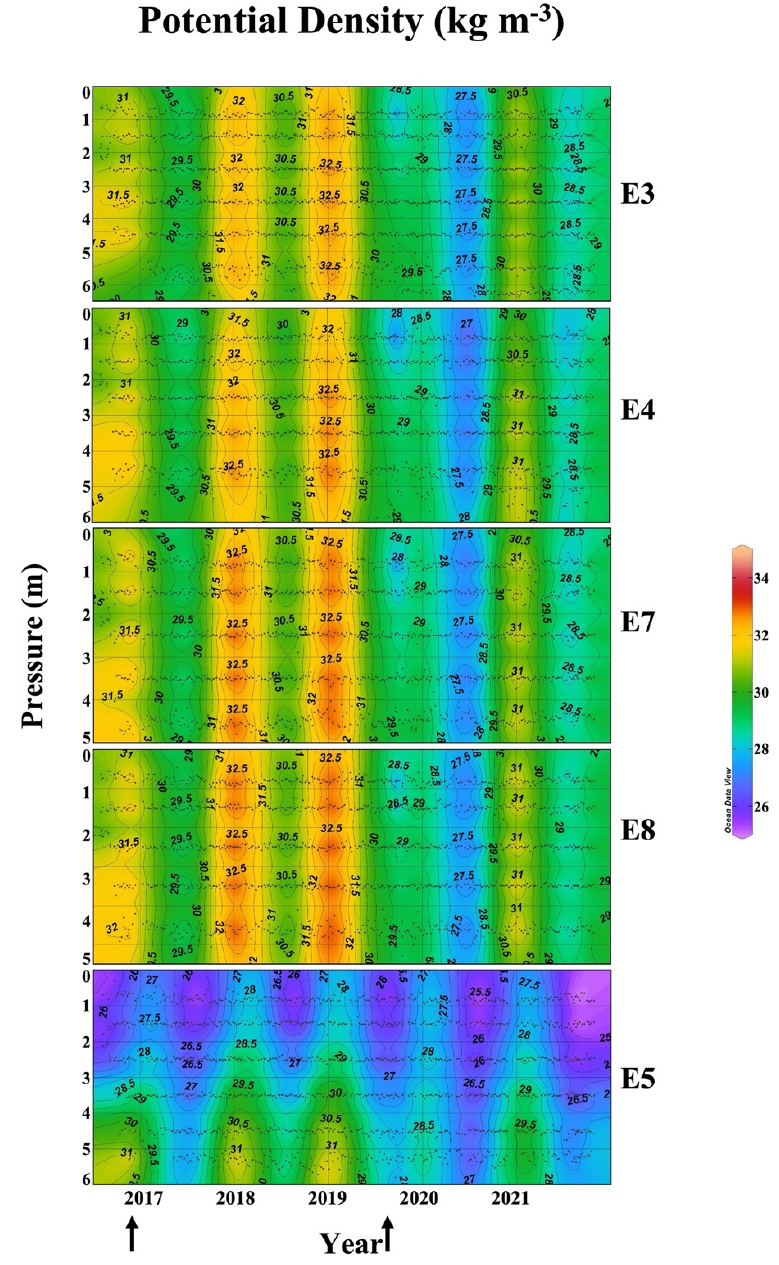
Figure 4. Temporal evolution of density at stations E3, E4, E7, E8, and E5 from August 2016 to October 2021. The vertical arrows indicate when the two DANA events occurred (December 2016 and September 2019, respectively).